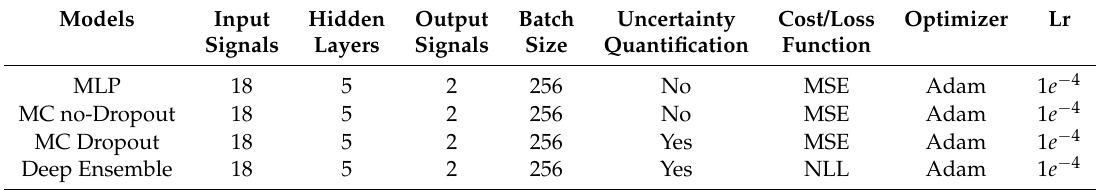
Table 4. Specification of the models, MSE: Mean Squared Error, NLL: Negative Log-Likelihood, Adam: Adaptive Moment Estimation, Lr: Learning rate, MLP: Multi Layer Perceptron, MC: Monte Carlo. Models